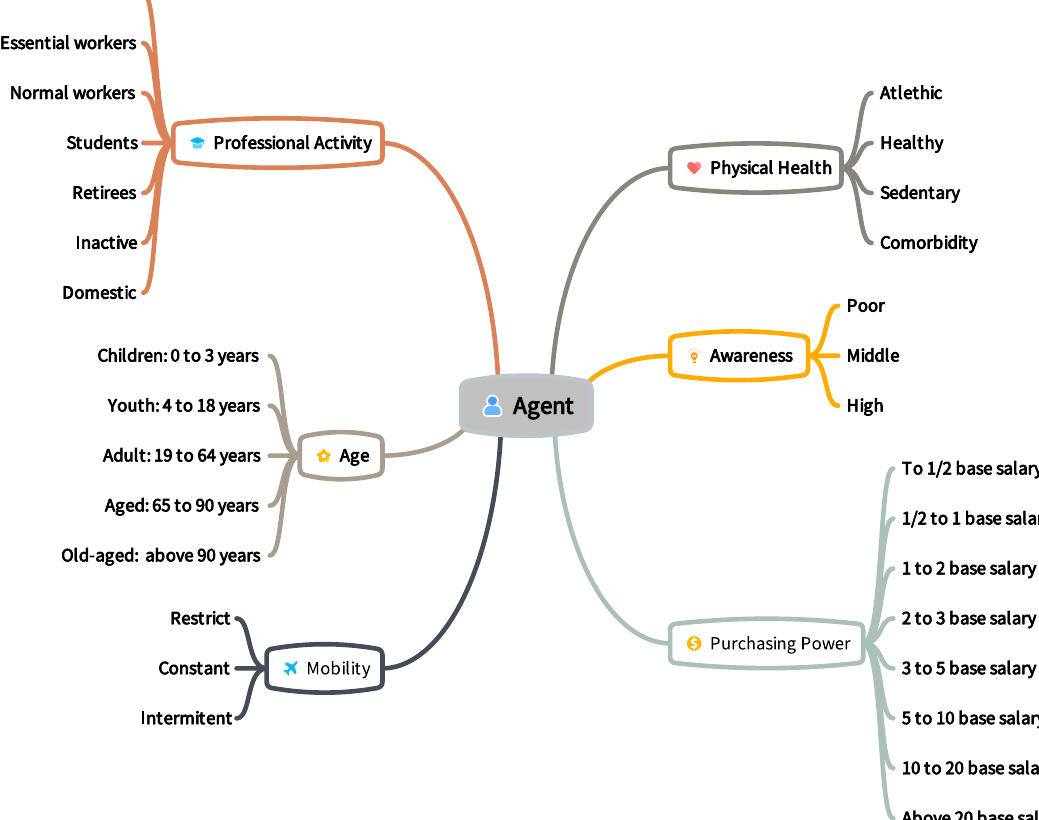
Figure 1. Set up the physiological and socio-economic aspects of the agent to detail the matrix that stores the agent’s attributes in the